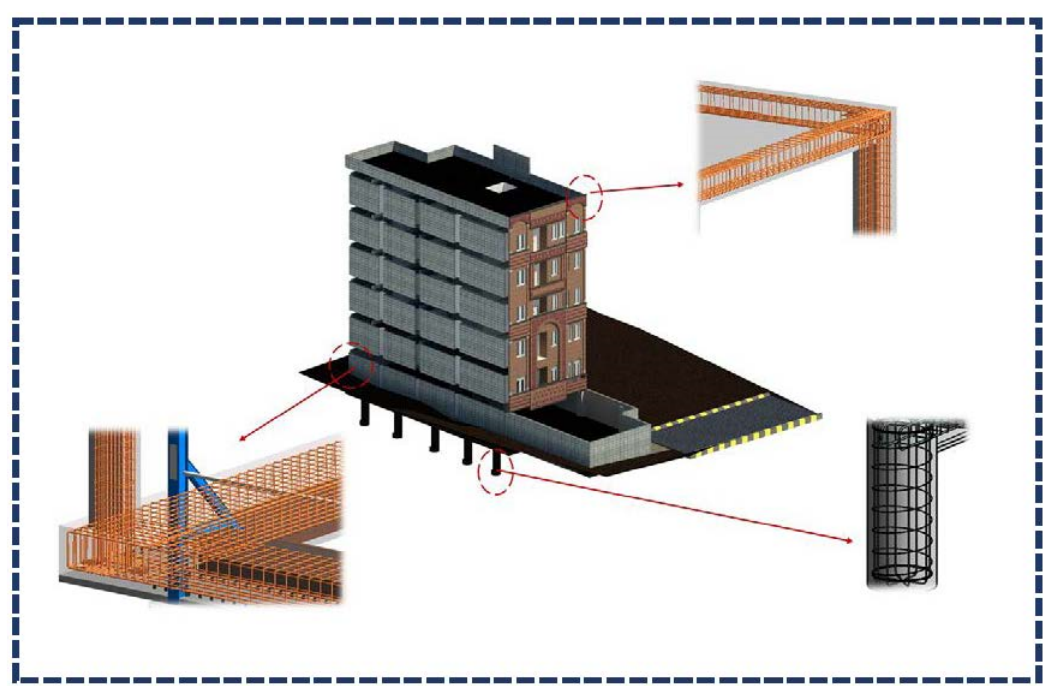
Figure 2. The project BIM-based modelling for resource trade-off.